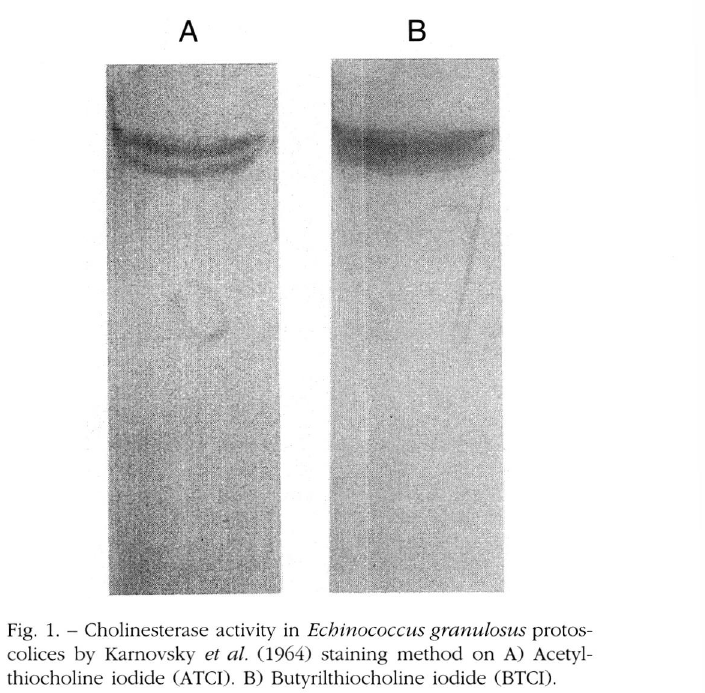
Fig. 1. - Cholinesterase activity in Echinococcus